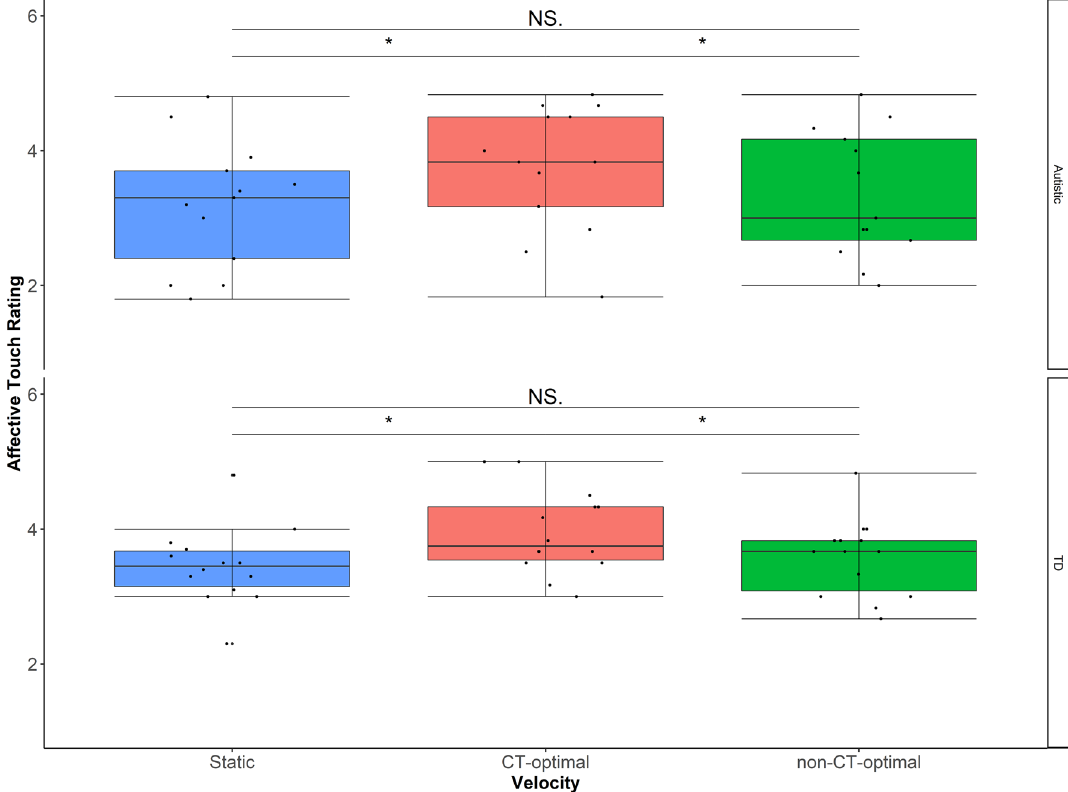
Figure 7. Data were collapsed across location and a group × velocity analysis was completed to show the main effect of Velocity. Here videos showing touch at CT-optimal velocities were rated higher than those depicting Static or non-CT-optimal velocity stroking and no differences between autistic children or typically developing children (bars ± 95%